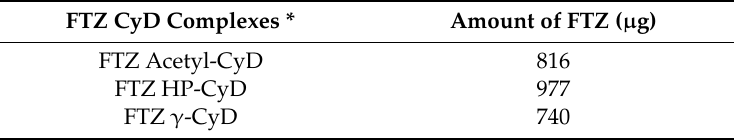
Table 4. Quantification of FTZ incorporated in CyD complexes.